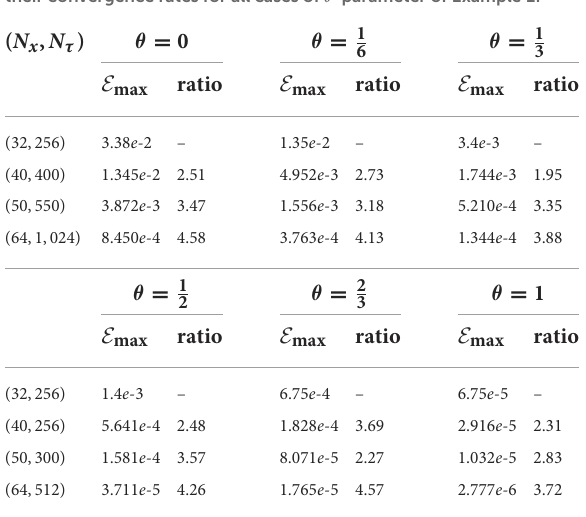
fixed and vice versa. The absolute errors at x and 27 π/ 16 are listed in Table 3 for various values of N τ together with the corresponding convergence rates β , which is defined by